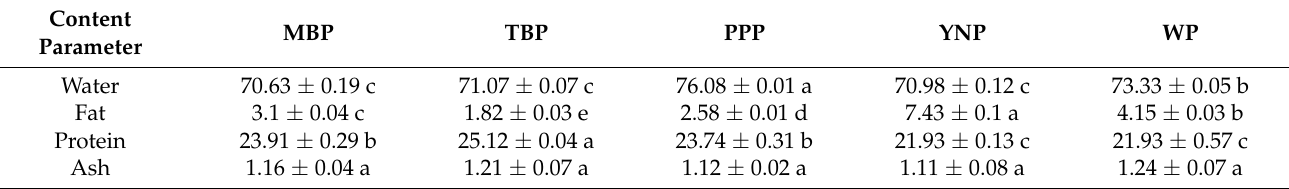
Table 2. Chemical compositions of pork samples (mg/100